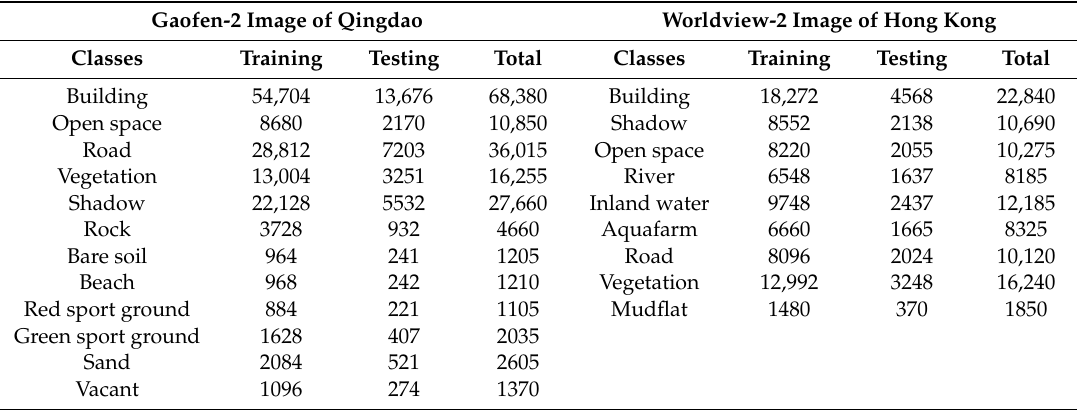
Table 1. Training and testing samples for the two study